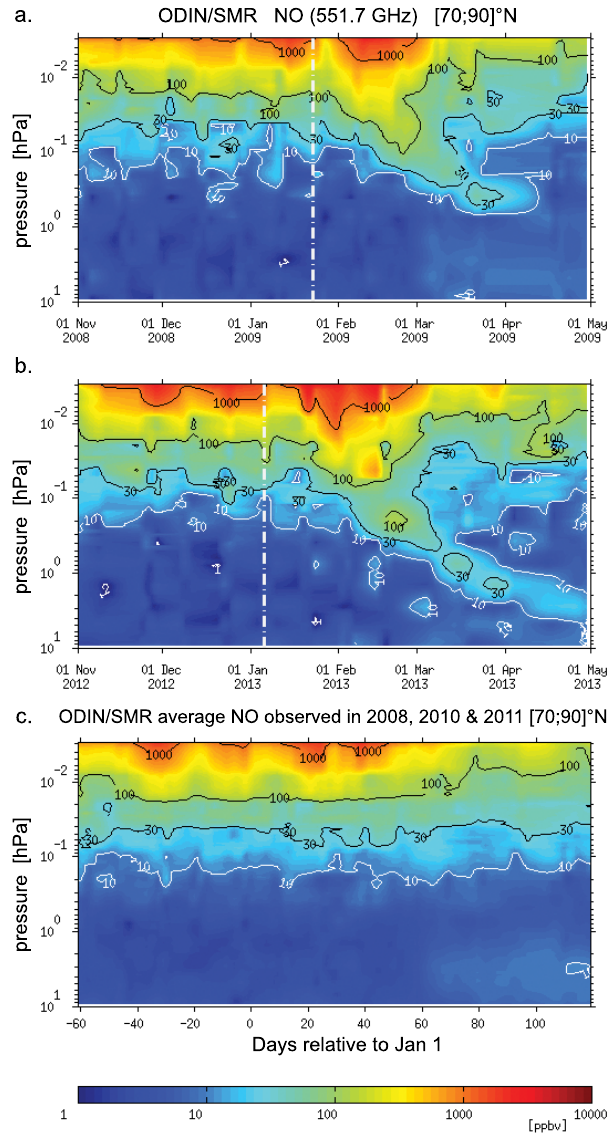
Figure 2. Upper stratosphere/mesosphere pressure–time sections of SMR zonal mean NO mixing ratio in the NH high latitudes (pole- ward of 70 ◦ N), from 1 November to 1 May, for the Arctic winter seasons 2008/2009 (a) and 2012/2013 (b) . The white dash-dotted lines indicate the central date of the warmings. Panel (c) represents the average NO measured during winters 2007/2008, 2009/2010 and 2010/2011, when no downward transport of NO was noticeable in the SMR data